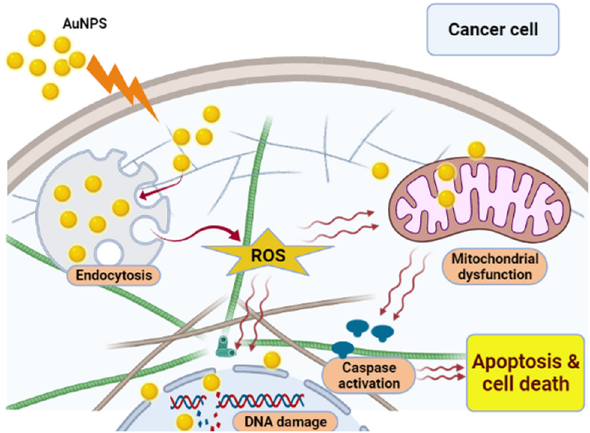
Figure 15: Mechanisms of anticancer activity for Au